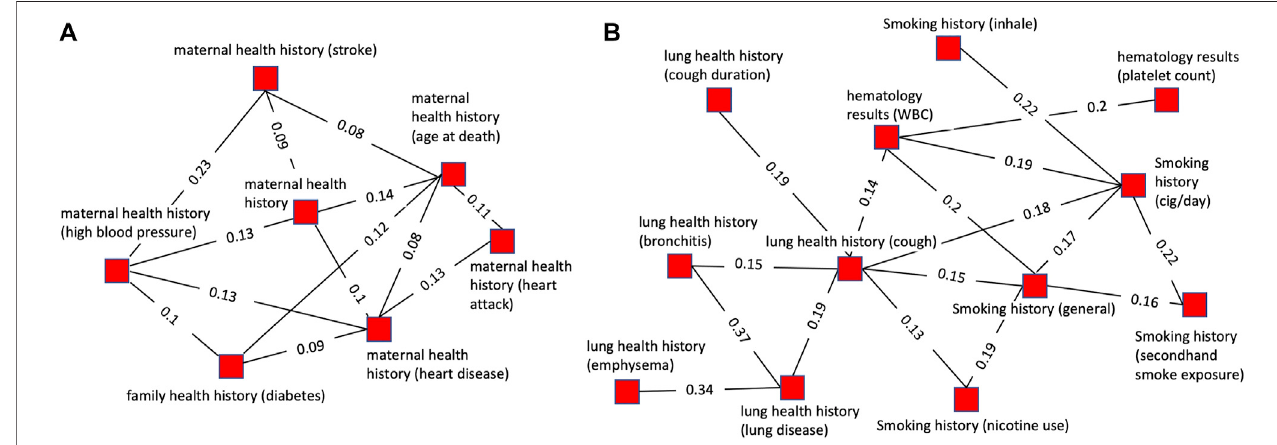
FIGURE4| Plotsofsingleclustergroupsdemonstratingclustercohesivenessaroundacentraltheme.Eachnodeisavariableclusterthatisamemberofthecluster group,andthegroupofinterconnectednodesisoneclustergroup. (A) Anexampleofaclustergroupwithclustersrelatingtomaternalhealthhistoryusingathresholdof 0.12 for pruning prior to community fi nding and 0.07 for viewing. (B) An example of a cluster group with clusters relating to cigarette smoking and lung health using a threshold of 0.18 for pruning prior to community fi nding and 0.12 for viewing.